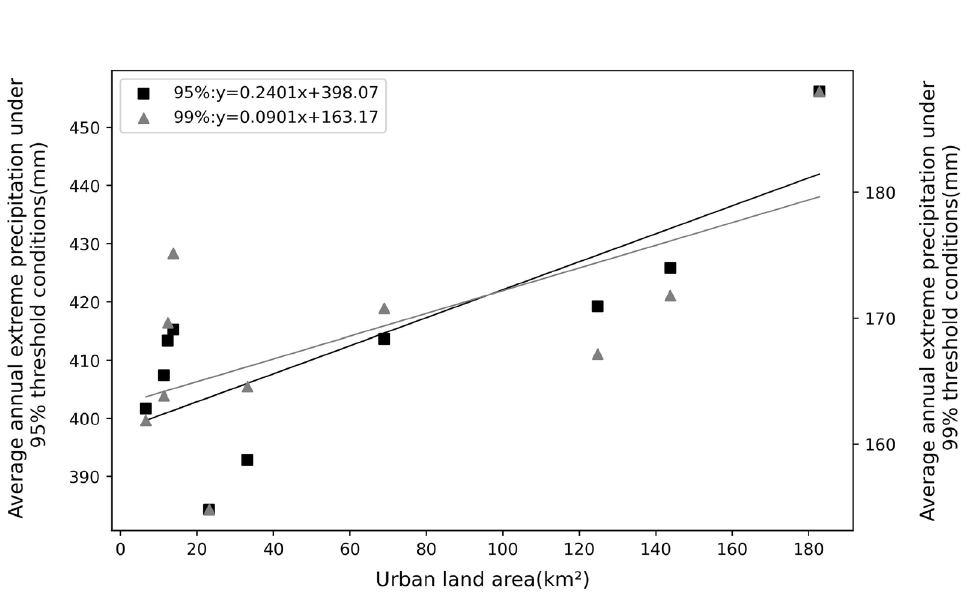
Figure 7. Plot of mean urbanization intensity versus average annual extreme precipitation for 5 periods.